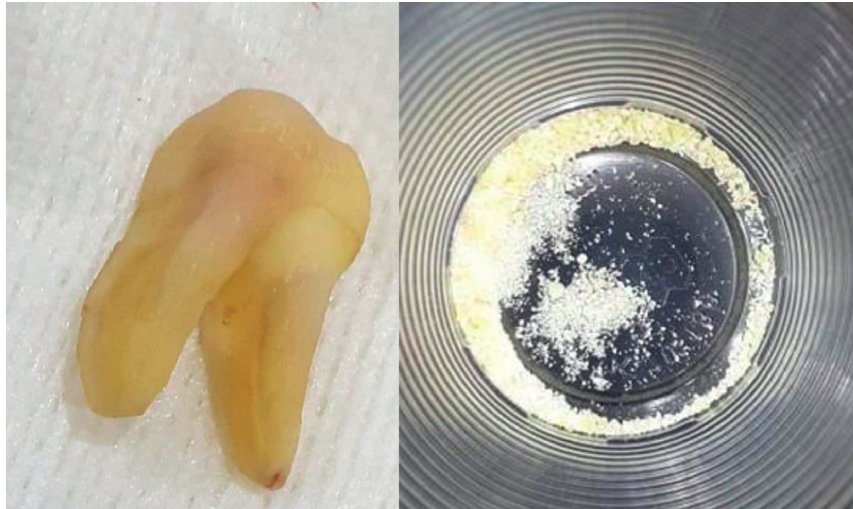
Figure 1: Preparation of ATBG material was performed from the extracted